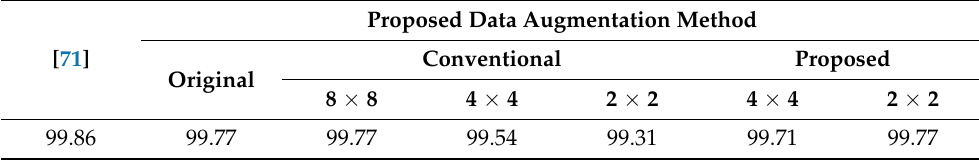
Table 8. Performance analysis of the proposed noise-based augmentation